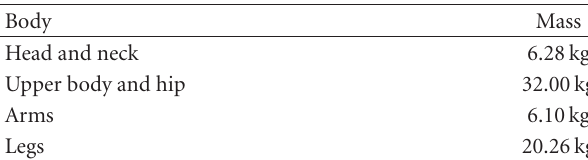
Figure 1: The parts of the human body. Table 1: The body segment masses.